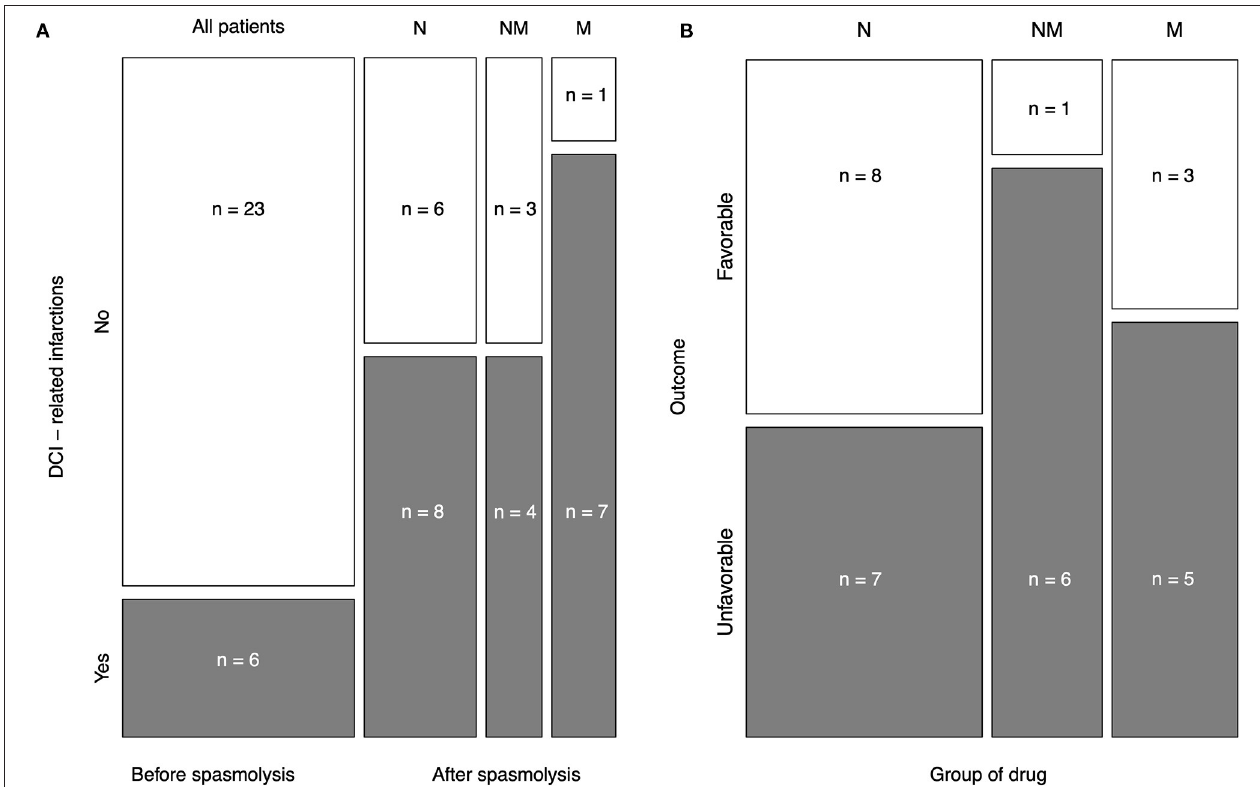
FIGURE 3 | Mosaic plot of both endpoints. Delayed cerebral ischemia (DCI)-related infarctions and the outcome in modified Rankin Scale (mRS) score after 6 months were chosen as study endpoints. (A) : DCI-related infarction before and after intraarterial spasmolysis due to the applied spasmolytic agent is shown. One case was excluded for DCI analysis due to missing prespasmolytic CT. The minority of cases (20.7%) already experienced DCI before intra-arterial spasmolysis. Nimodipine and the combination of milrinone and nimodipine revealed the same proportion of DCI (57.1%). In most cases (87.5%), the monotherapy with intra-arterial milrinone could not prevent DCI-related infarctions. (B) : The outcome was subdivided into favorable (mRS 0–3) and unfavorable (mRS 4–6). Patients who received nimodipine only had the best outcome after 6 months assessed by mRS, followed by only milrinone-treated patients and patients after combined therapy. N = nimodipine, M = milrinone, NM = nimodipine and